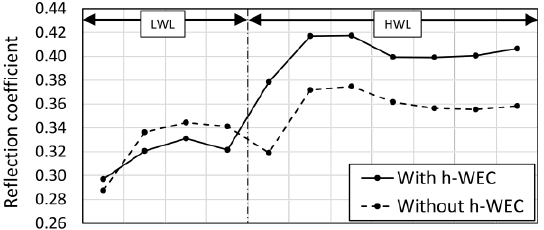
Fig. 17. Comparison of the reflection coefficient with and without the h-WEC integrated into the breakwater.